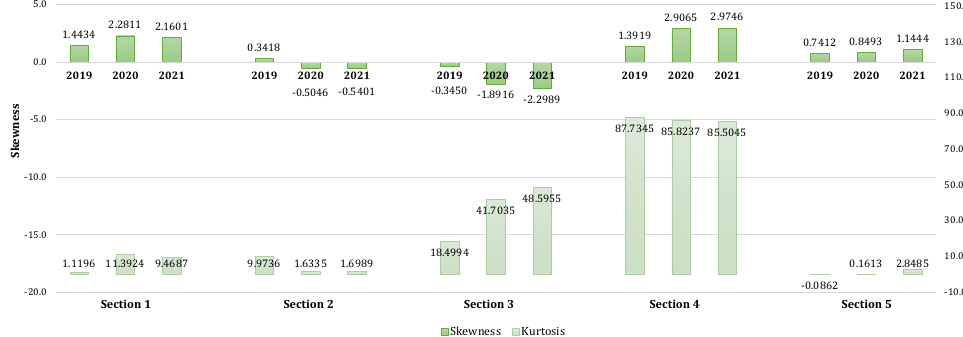
Figure 23. The change of the alignment parameter values of the selected sections over time, considering the skewness and kurtosis